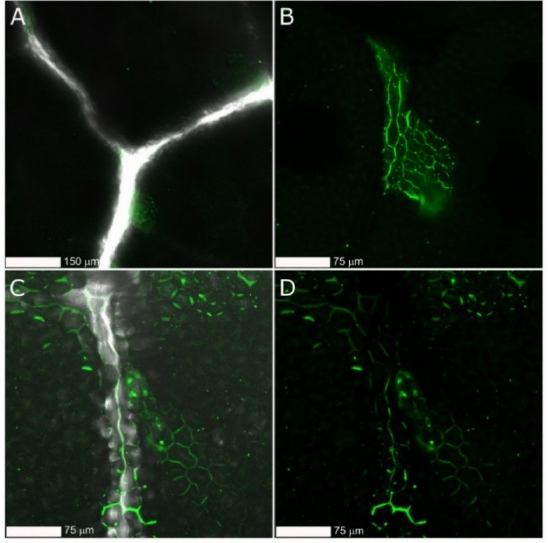
Figure 9. Confocal microscopy at higher resolution of cucumber leaves treated with dsRNA*FITC ( A , C ) and gCD-dsRNA*FITC ( B , D ) after washing the leaves with water.